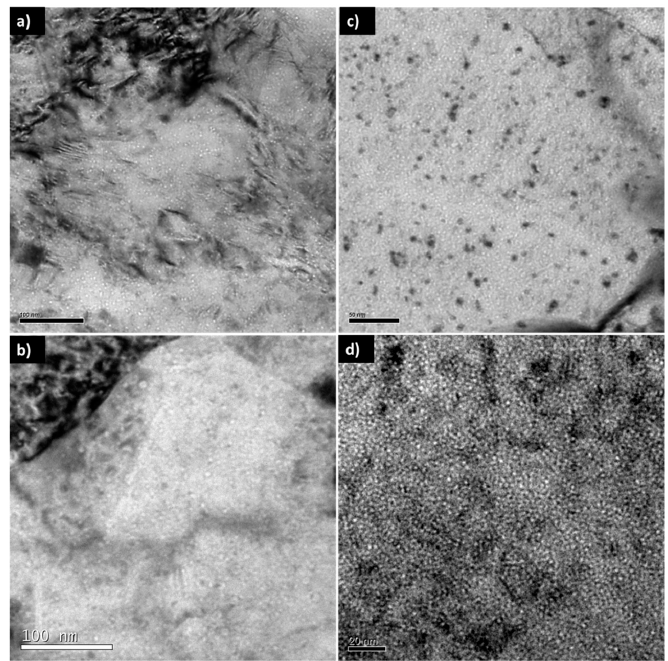
Figure 17. TEM micrographs of the microstructure of EU-ODS EUROFER ( left ) and EUROFER97 ( right ) steel with a He content of ~700 appm He ( a ) and ( c ) implanted at room temperature with stair-like profile from 2 to 15 MeV and ( b ) and ( d ) implanted at room temperature with stair-like profile from 2 to 15 MeV and annealed at 450 °C for 100 h.